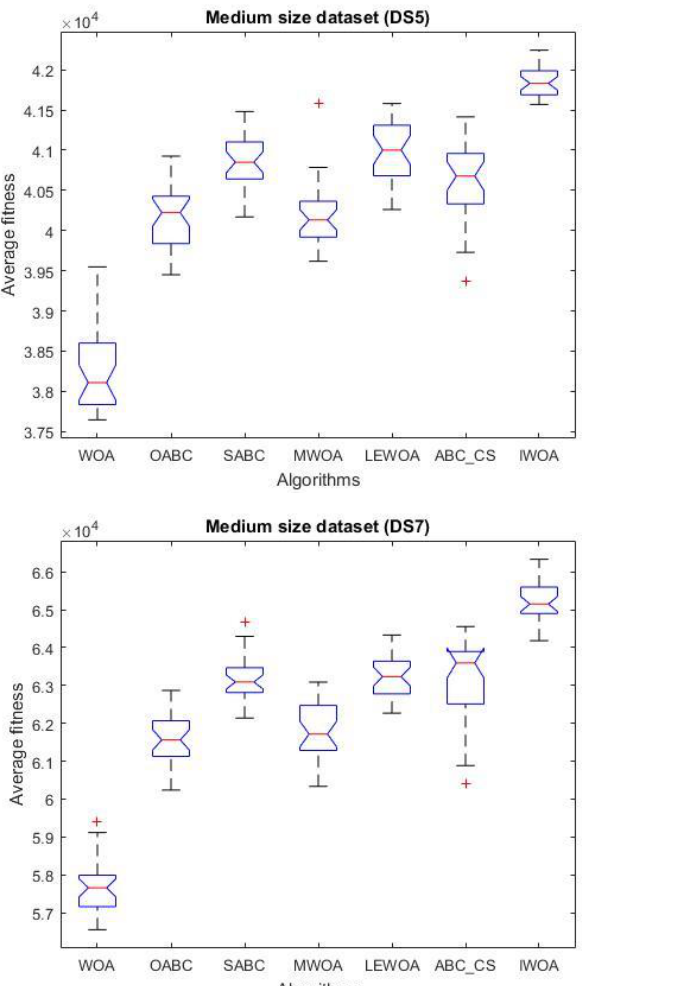
Figure 2. Boxplots for the average fitness value obtained using the compared algorithms for the small-sized datasets.